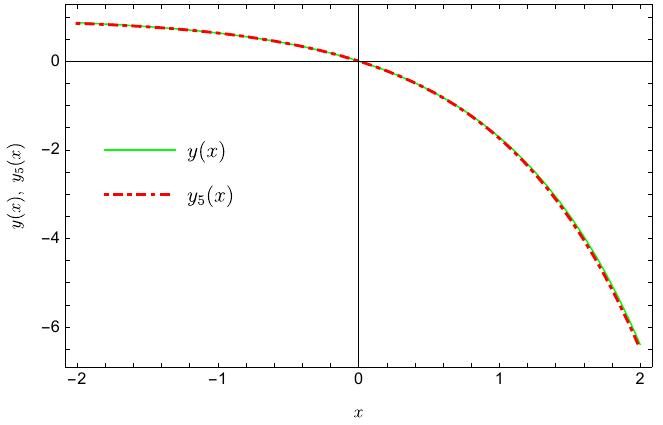
Figure 9. Exact solution and the approximate solution y 5 ( x ) .